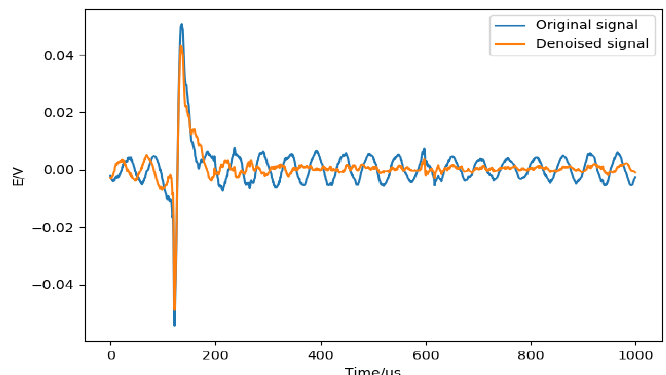
Figure 4. An example of zero-phase digital filtering. The blue line indicates data before filtering, and the orange line indicates data after filtering.